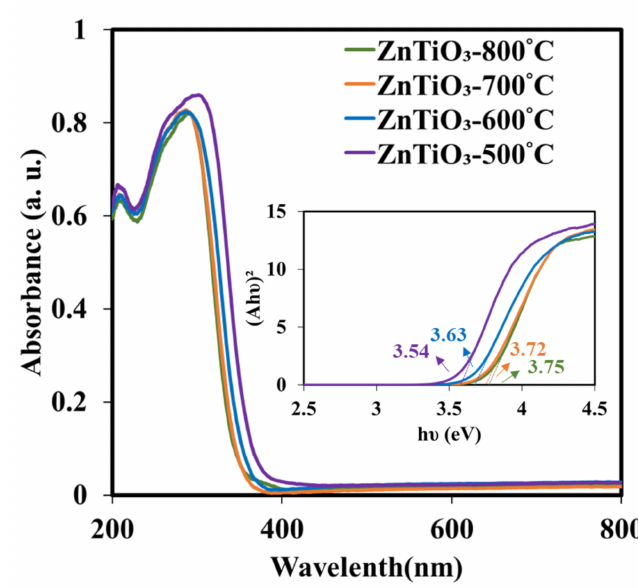
Figure 6. UV-Vis results of ZnTiO 3 calcinated at 500~800 ◦ C.